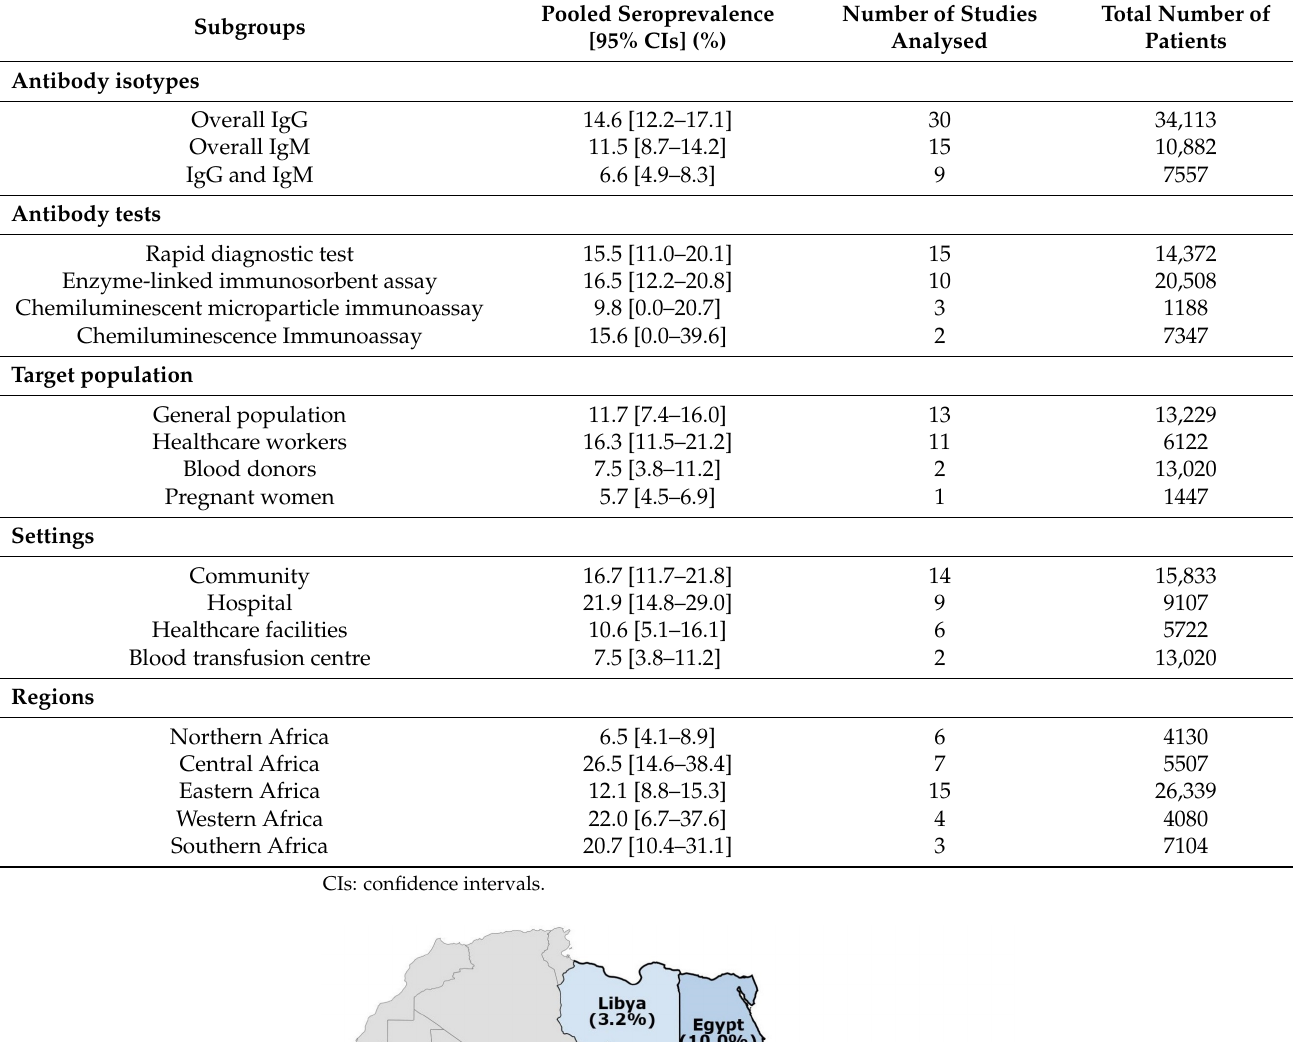
Table 2. Subgroup analyses estimating the pooled seroprevalence of SARS-CoV-2 antibodies in Africa.